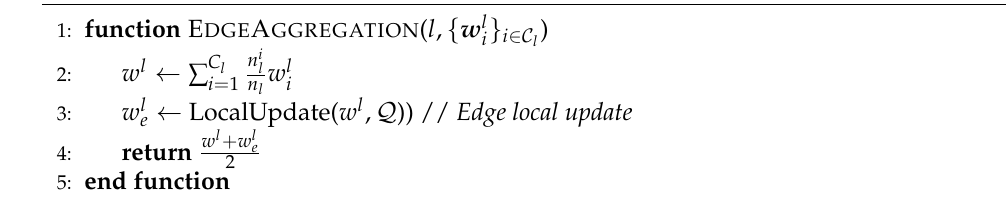
Algorithm 3 Edge aggregation